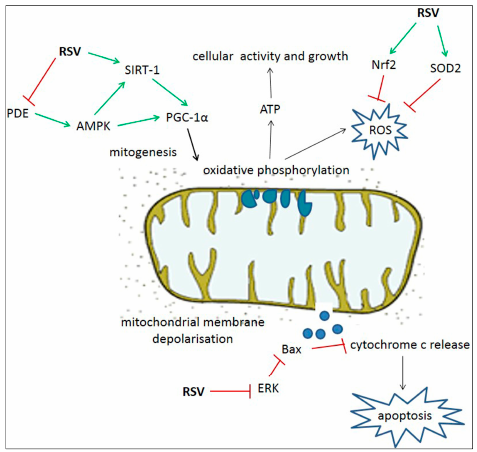
Figure 1. Summary of proposed beneficial effects of resveratrol on mitochondrial respiration and cell survival. Abbreviations: AMP-activated protein kinase (AMPK); B-cell lymphoma 2-associated X protein (Bax); extracellular signal-regulated kinase (ERK); nuclear factor-E2-regulated factor-2 (Nrf2); phosphodiesterase (PDE); peroxisome proliferator-activated receptor- γ coactivator α (PGC-1 α ); resveratrol (RSV); reactive oxygen species (ROS); sirtuin 1 (SIRT-1); super oxide dismutase 2 (SOD2).